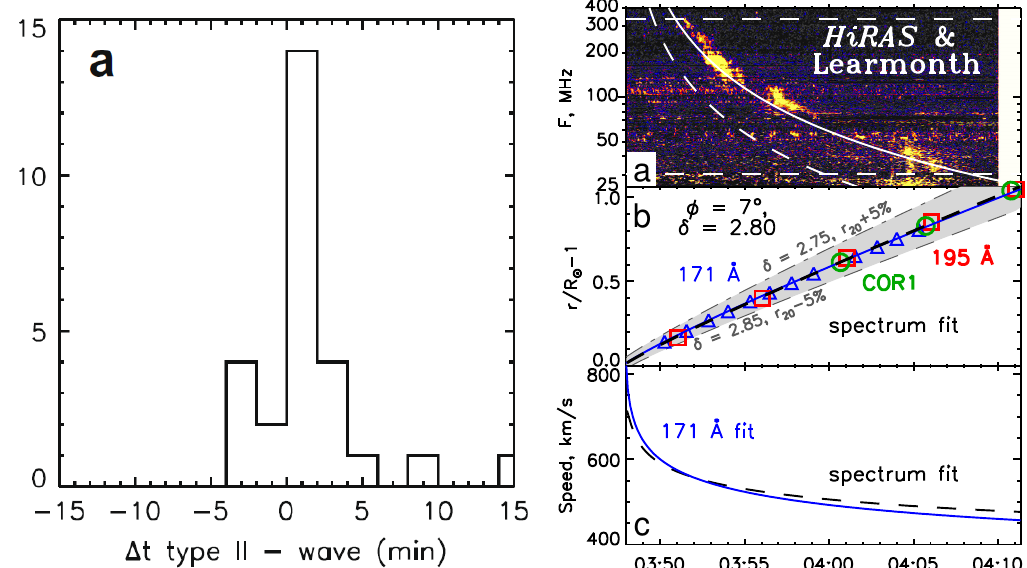
Figure 15: Left : Histogram of the time lag between the start of the type II burst and the first observation of a Moreton wavefront (in minutes). Note that in most events, the type II burst and the wave appear close in time to each other. Right : Kinematics of the off-limb expansion of the coronal wave of 2010 Jan 17 and the associated type II burst. The kinematics of the type II burst were obtained by fitting the radiospectrum with a power-law density model. (a) Dynamic radio spectrum of the burst (white line: harmonic emission lane; dashed white line: presumable fundamental emission). (b) Height-time plot of the wavefronts observed with EUVI at 171 ˚A (blue), 195 ˚A (red), and COR1 (green). The blue line is a power-law fit to the 171 ˚A heights, while the black dashed line is a fit of the type II burst frequencies converted into heights. (c) Speed-time plot of the speeds obtained from a power-law fit of the height of coronal wavefronts observed at 171 ˚A (blue line) and the speeds obtained from the fit of the type II burst frequencies (dashed line). Note the good agreement between the type II burst and the wavefront’s expansion. Images reproduced with permission from [left] Warmuth (2010), copyright by COSPAR, and [right] Grechnev et al. (2011a), copyright by